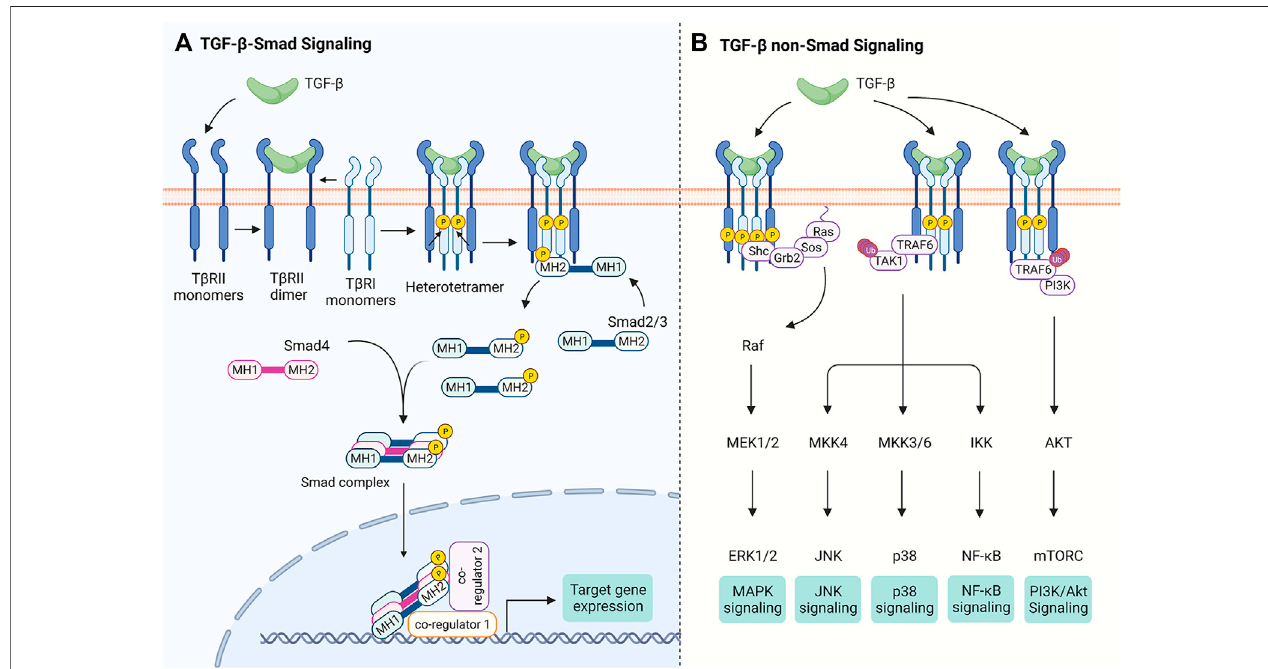
FIGURE 1 | The TGF- β Signaling Pathways. Binding of TGF- β to T β RII leads to the tetramer assembly of monomeric T β RII and T β RI receptors. (A) In Smad- dependent TGF- β signal transduction, T β RII trans-phosphorylates T β RI and activates its kinase activity, which in turn phosphorylates Smad2/3 at the C-terminal tail. Phosphorylated Smad2/3 form a trimeric complex with Smad4 and is translocated into the nucleus. The Smad complex binds DNA via their MH1 domains and controls gene expression through interacting with other transcription co-regulators. (B) TGF- β receptors trigger non-Smad signaling pathways. For instance, TGF- β receptorshavebeenreportedtorecruitShc,Grb2andSostoactivateRas,therebyinitiatingMAPKsignaling.TGF- β receptorsalsoactivateTAK1throughTRAF6,which is required for TGF- β -induced JNK, p38 and NF- κ B activation. It has been proposed that interaction of TRAF6 with T β RI also leads to PI3K/Akt activation. Figure is created with